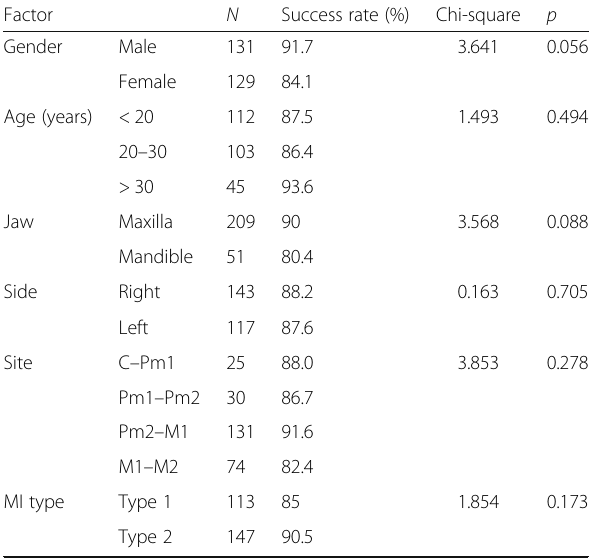
Table 1 Descriptive statistics and comparison of success rates between different categories